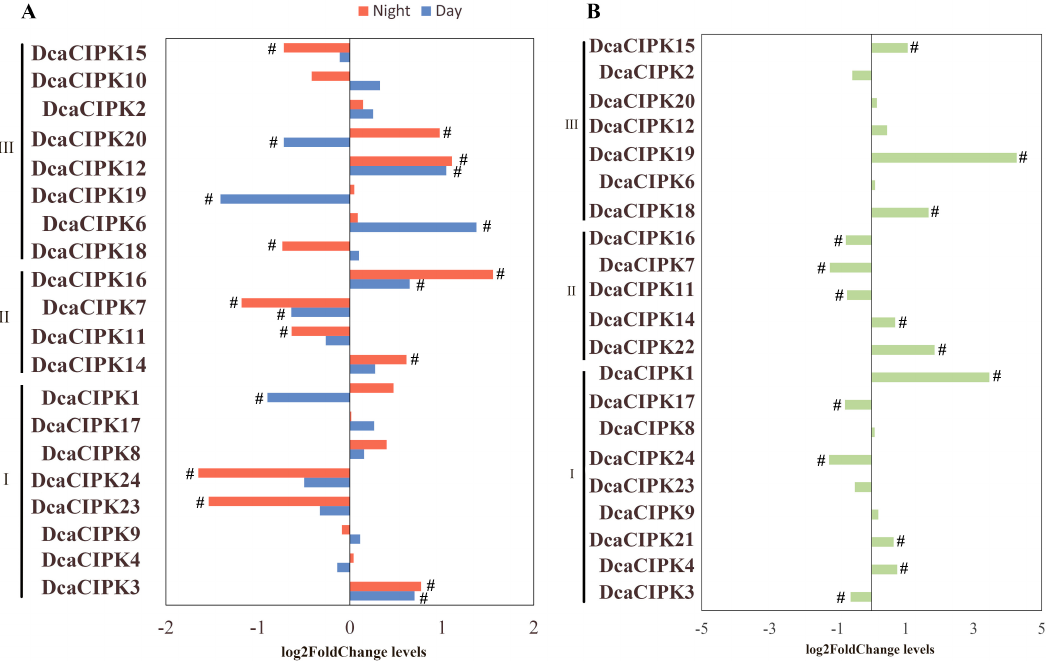
Figure 5. ( A ) Expression levels of Dca CIPK genes under drought stress vs (normal condition, moist matrix). ( B ) Expression levels of Dca CIPK genes under cold stress (vs. control). Adjusted p -value < 0.05. # indicates fold change >1.5.